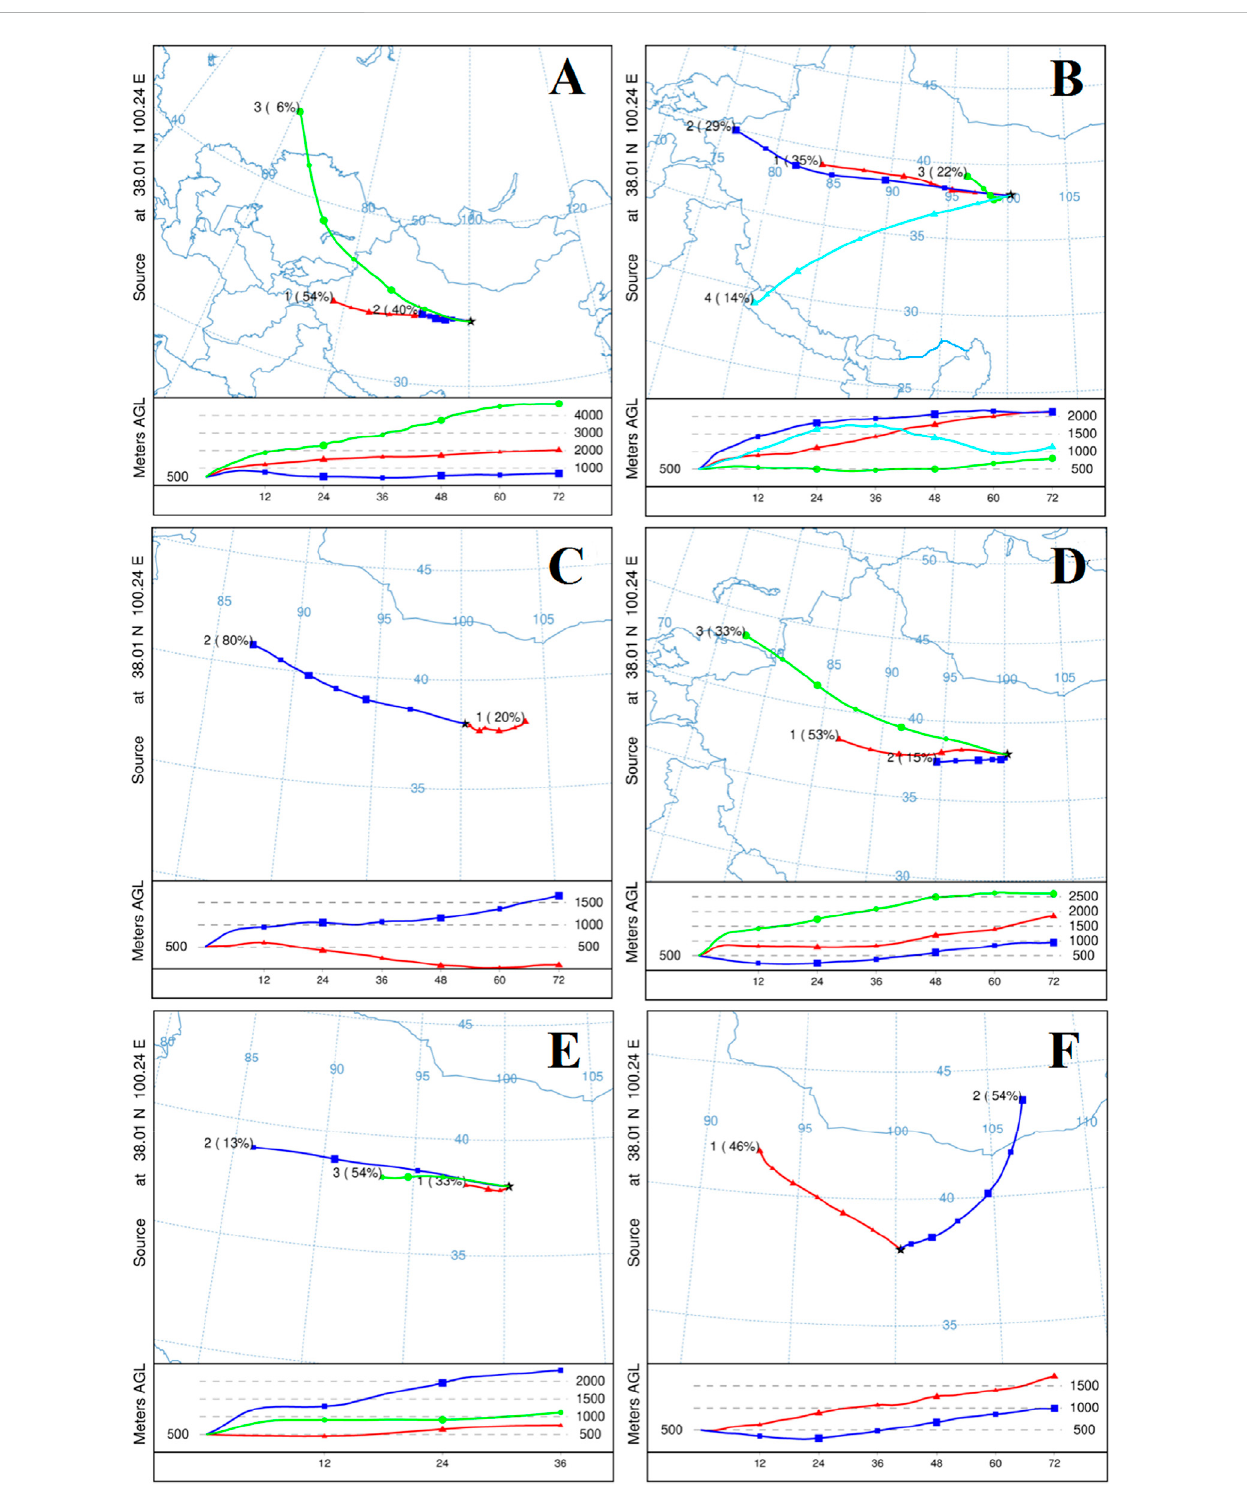
FIGURE 13 Clustering analysis of 72 h backward trajectory of Heihe sampling site, where (A) is from November to December 2018; (B – D) are January-February, March and November-December 2019, respectively; (E) (F) are January-February and April 2020, respectively.